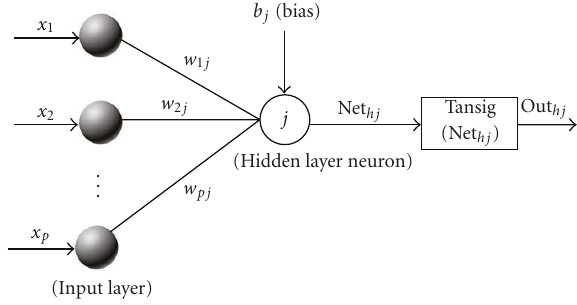
Figure 3: Input and output of a single hidden layer neuron.